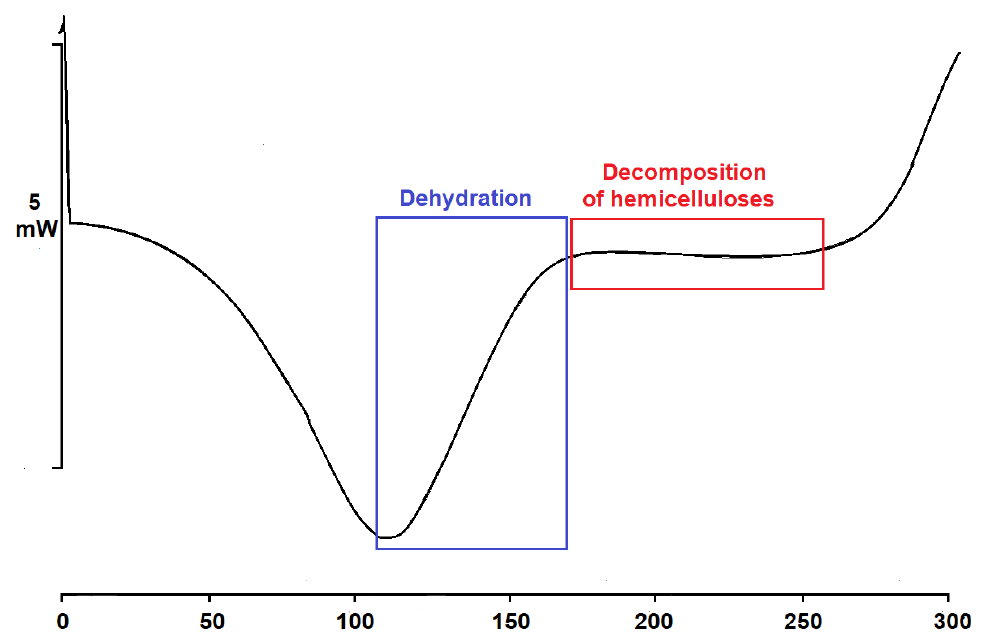
Figure 3. Effect of temperature on chemical reactions of black locust wood.